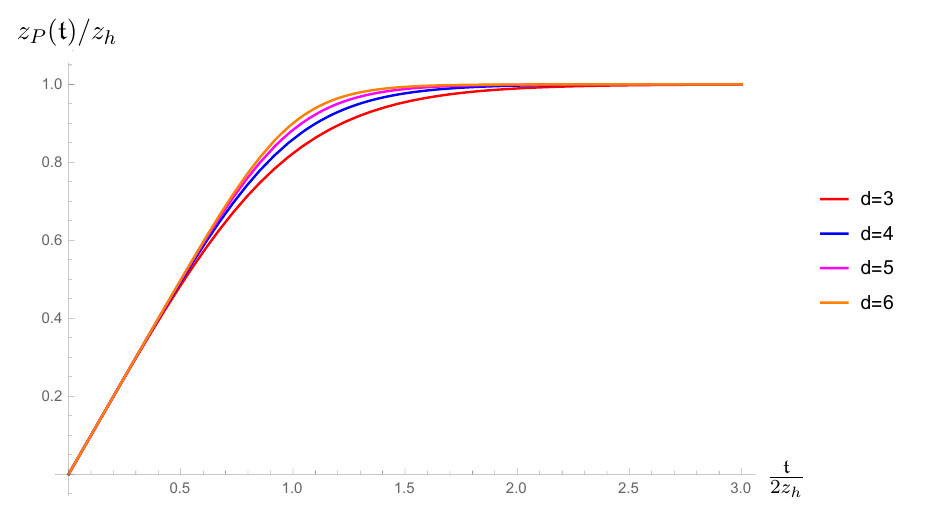
Figure 3 . The plots showing the position of the plane P as a function of time for d = f 3 ; 4 ; 5 ; 6 g . It is evident from these plots that z P ( t ) ! z h when t (cid:24) z h